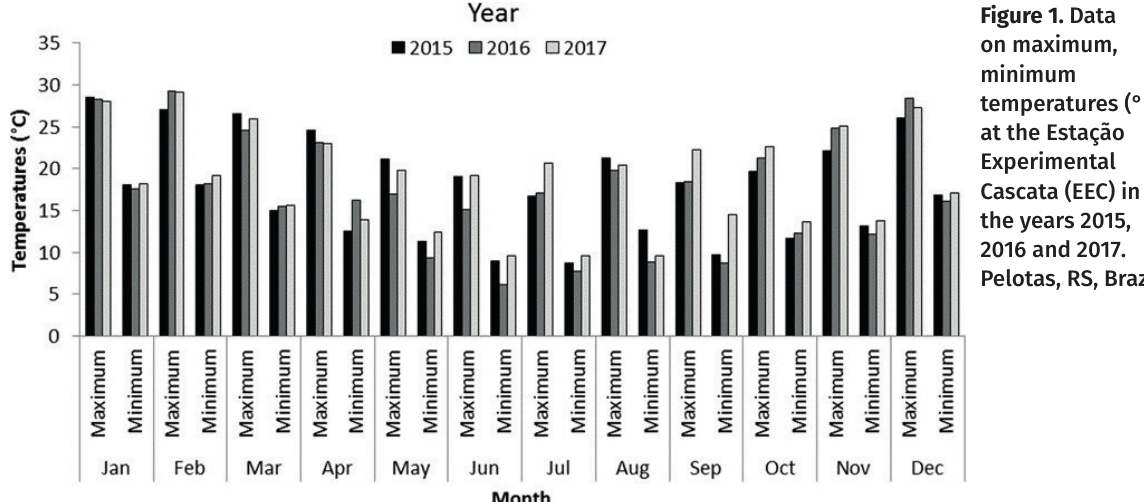
Figure 1. Data on maximum, minimum temperatures (°C) at the Estação